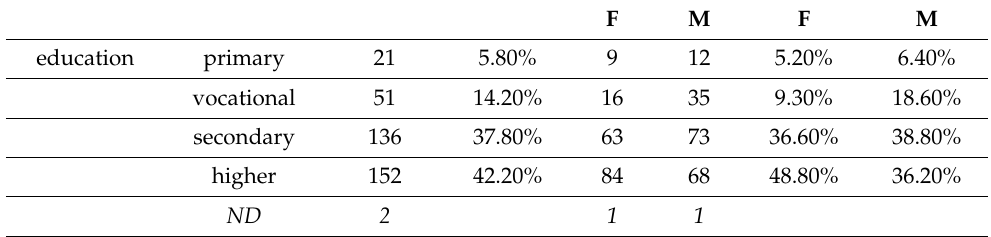
Table 3. Education of the respondents.